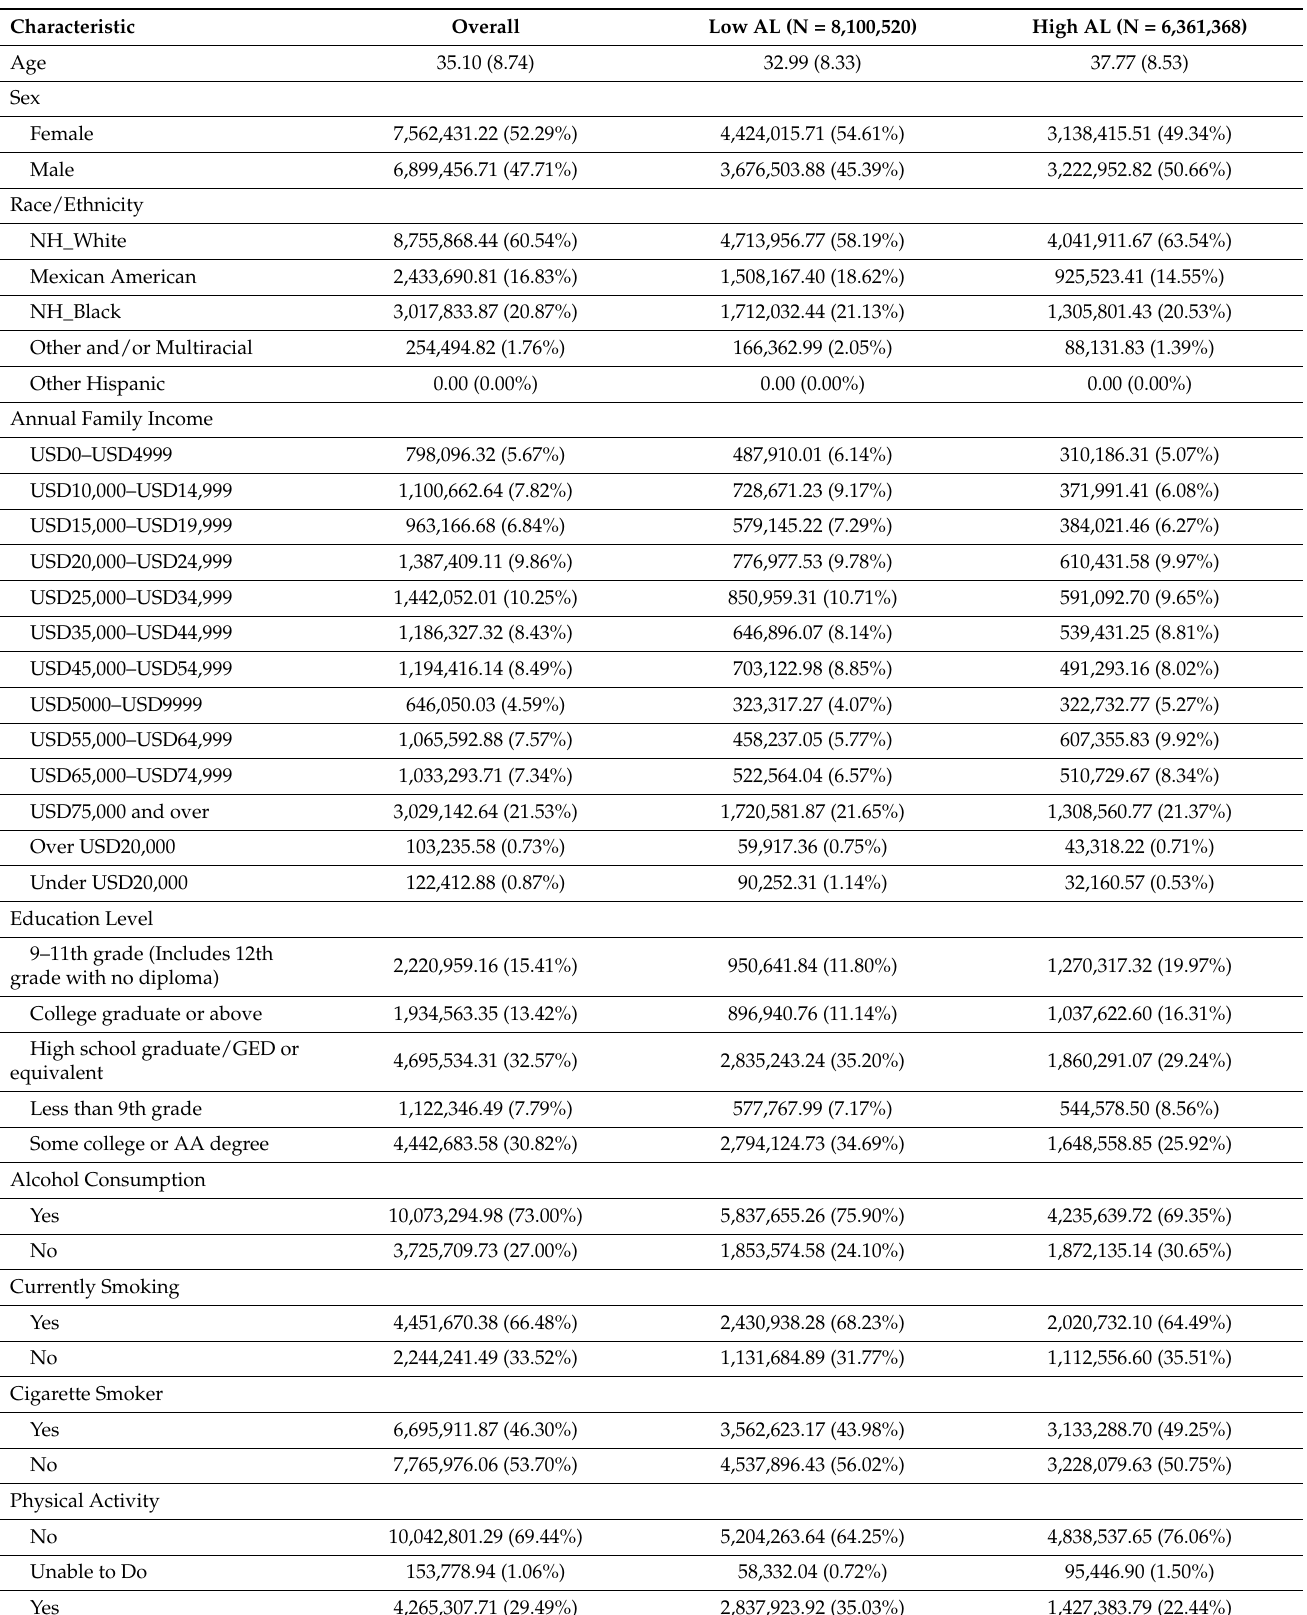
Table 1. Means (standard error) of critical variables by AL